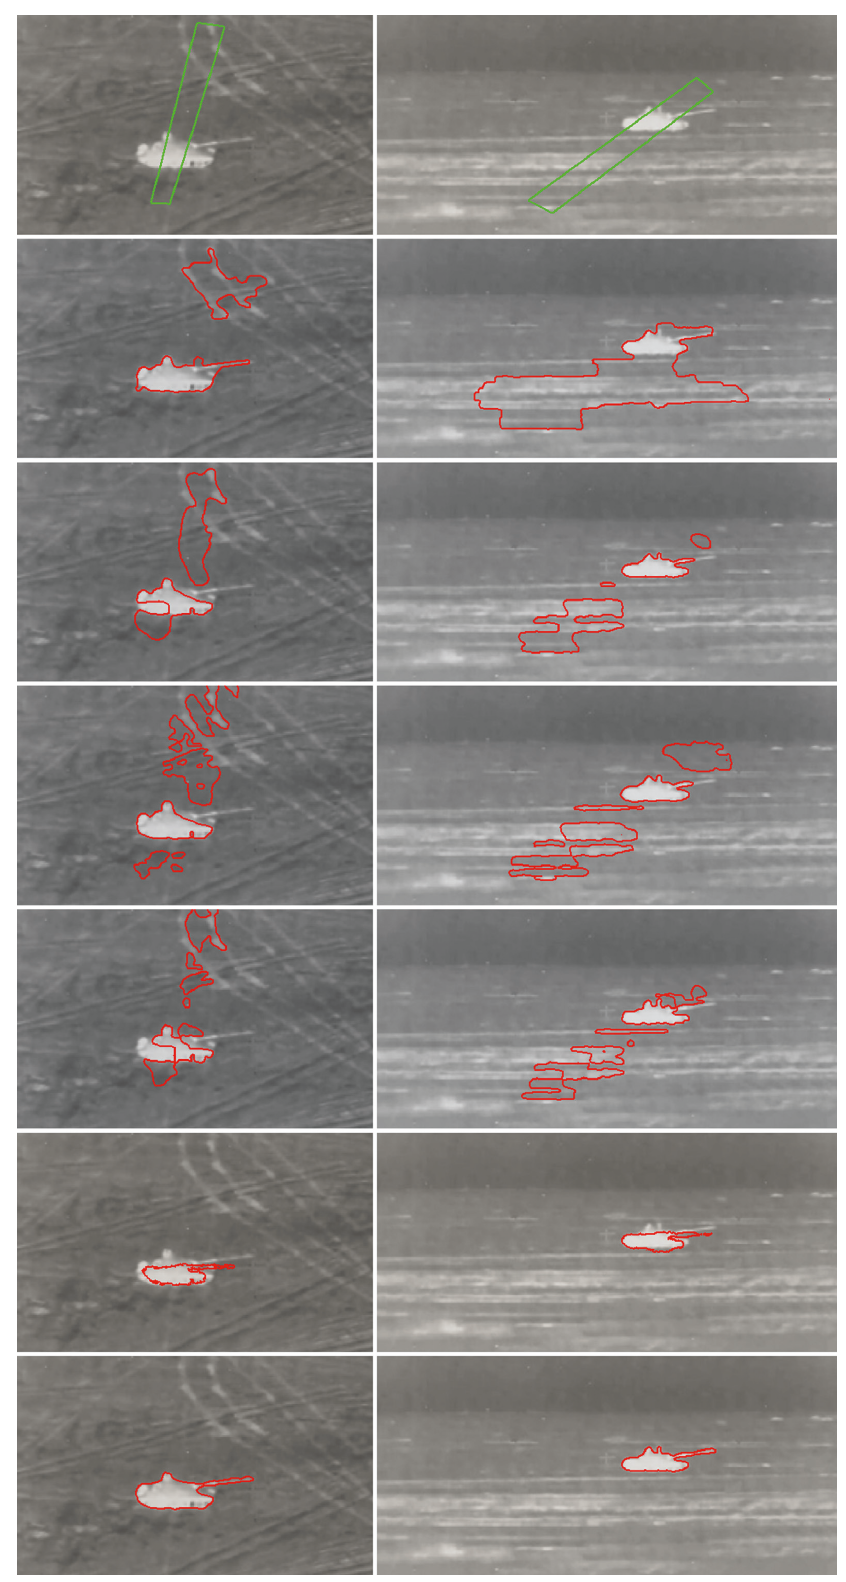
Figure 3: A set of comparison segmentation experiments on real infrared tank images in the case of multiple shape priors. The first row is the input images along with initial contours. The second to seventh rows are the segmentation results by using the LSEWR, RSF, LGDF, LIF, CREMERS, and our SP-LEM models, respectively. The relevant task parameters are N � 1, μ � 0 . 03, Δ t � 6, σ � 2 . 5, and ε � 1 .